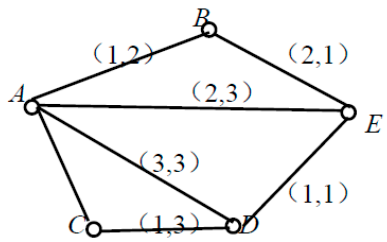
Figure 3. The structure chart of traveling salesman problems (bTSPs).